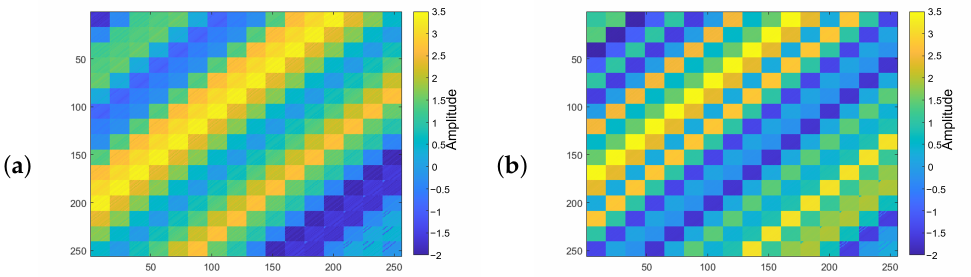
Figure 2. Block Hankel matrix for frequency slice of ( a ) 20 Hz, ( b ) 50 Hz. The color bar represents the absolute value of the FFT of input data in the mentioned frequency.